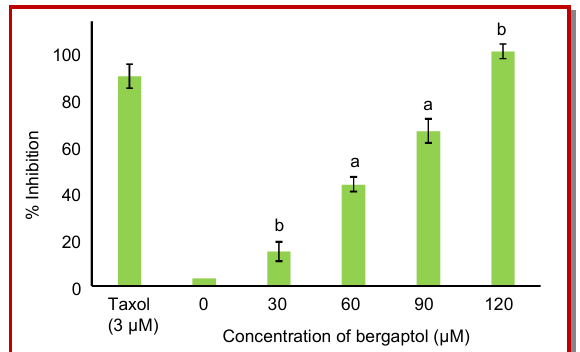
Figure 2: Cytotoxic effect of bergaptol in human breast cancer cells (MCF-7). Data are shown as the mean ± SD of three inde-